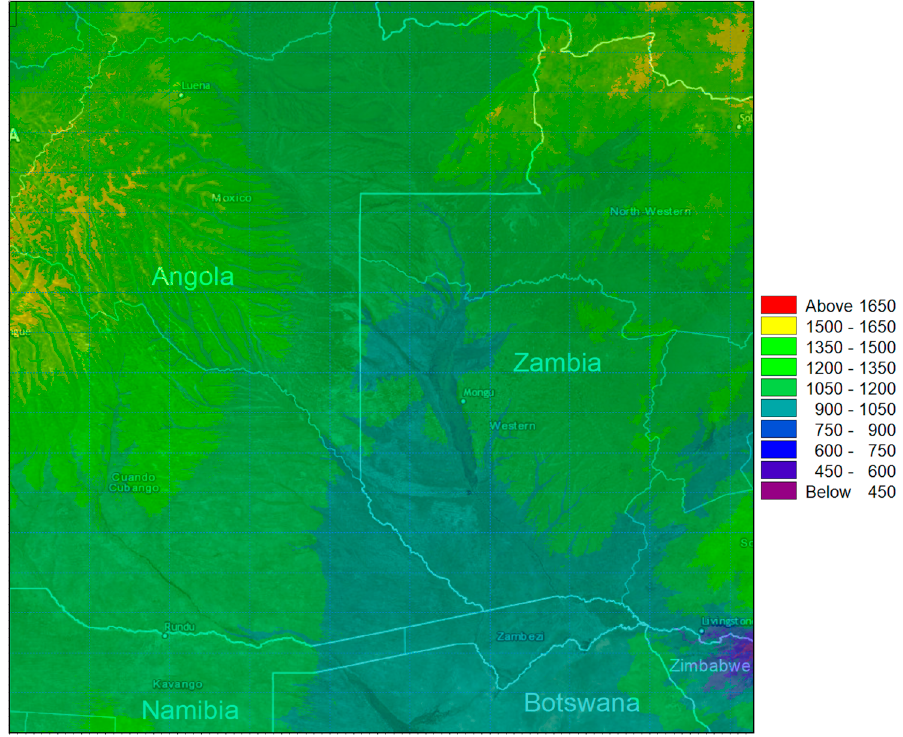
Figure 14. Screenshot of the MIKE-SHE topology grid input of the Upper Zambezi River Basin showing elevations (meters above sea level) based on data extracted using the Large Basin Data Portal tools from the Google Maps Elevation dataset.